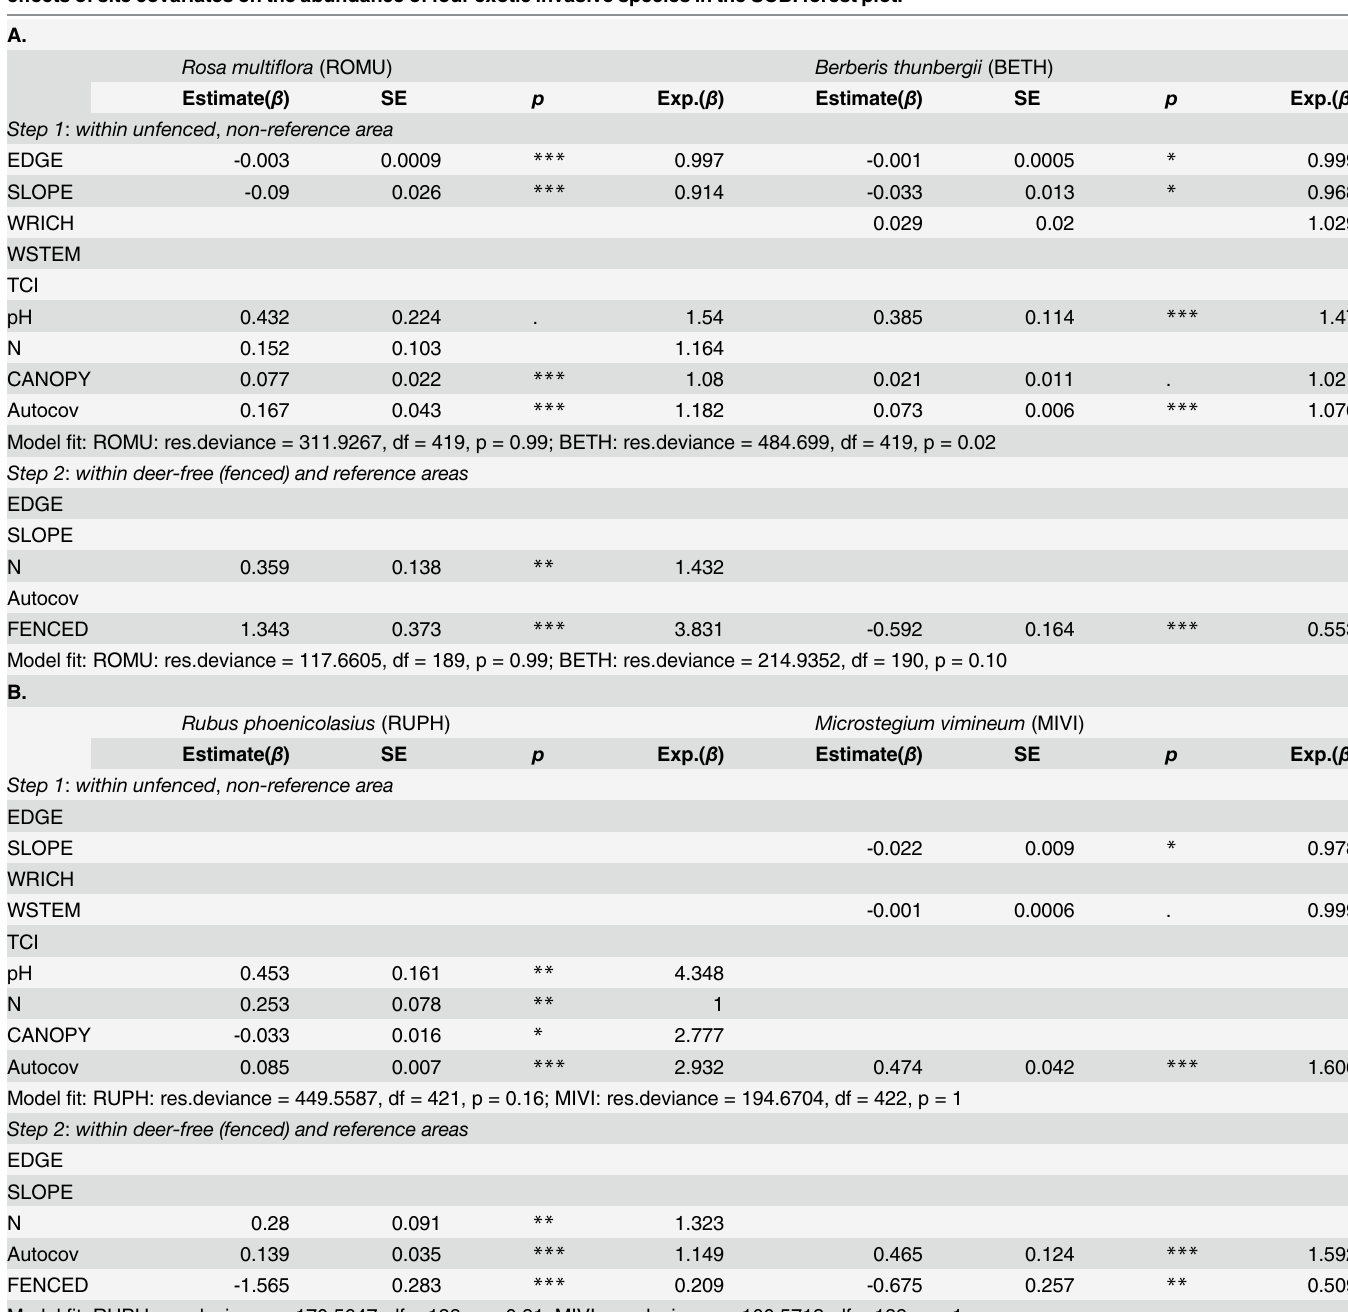
Table 3. Parameter estimates, standard errors and p -values ( *** < 0.001, ** < 0.01, * < 0.05,. < 0.1) for final generalized linear models estimating the effects of site covariates on the abundance of four exotic invasive species in the SCBI forest plot. A. Rosa multi fl ora